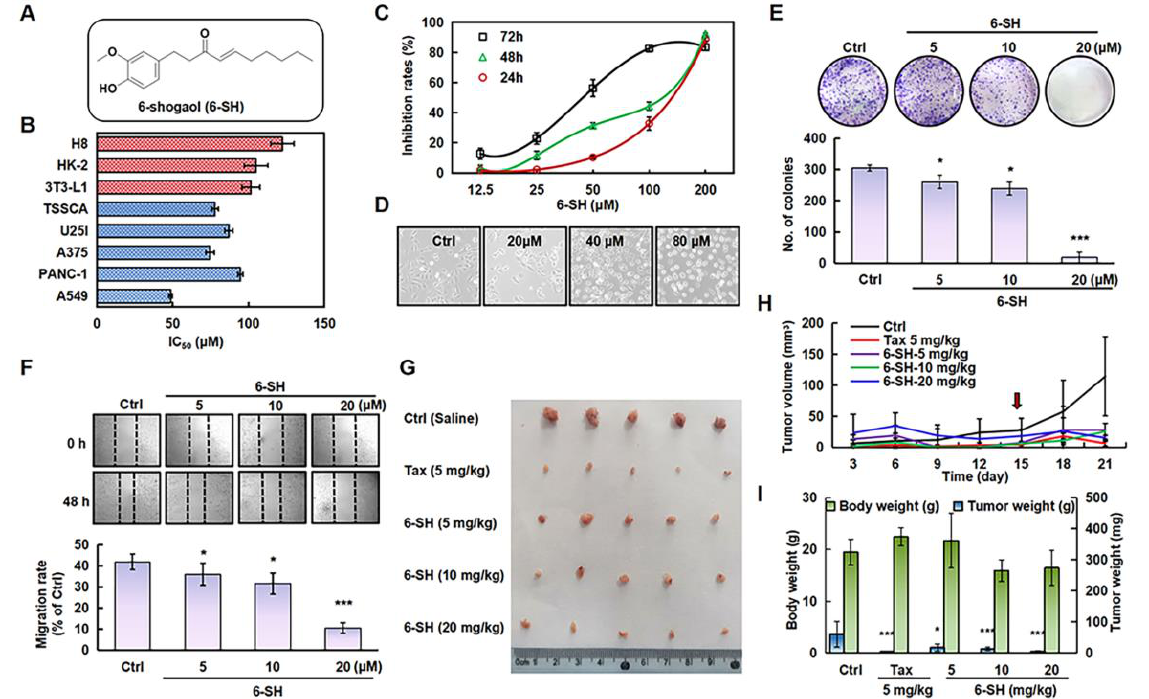
Figure 1. 6-SH inhibited the growth of A549 cells in vitro and in vivo. ( A ) Structure of 6-SH. ( B ) The different cell lines were treated with 0 – 200 µM 6-SH for 72 h, the IC 50 value was measured ( n = 3). ( C ) Cells were treated with 0 – 200 µM 6-SH for different hours, and the cell viability was assayed ( n = 3). ( D ) The effect on cell density of 6-SH (0 – 80 μM) for 24 h. ( E ) Cells were incubated with 0 – 20 µM 6-SH for 14 days, the Giemsa staining was performed; histogram shows the number of colonies ( n = 3). ( F ) Cells were incubated with 0 – 20 µM 6-SH for 24 h, the cell migrations were analyzed, and the histogram shows the migration rate ( n = 3). ( G – I ) A549 cells were injected subcutaneously into nude mice. Then, they were treated with Tax (5 mg/kg/day, as a positive control) and 6-SH (5, 10, or 20 mg/kg/day) for one week after tumor formation (the red arrow at Day 14 represents the first day of treatment). The tumor volume was calculated ( n = 5). Values represent the means ± SD. * p < 0.05, *** p < 0.001 versus “Ctrl” group.